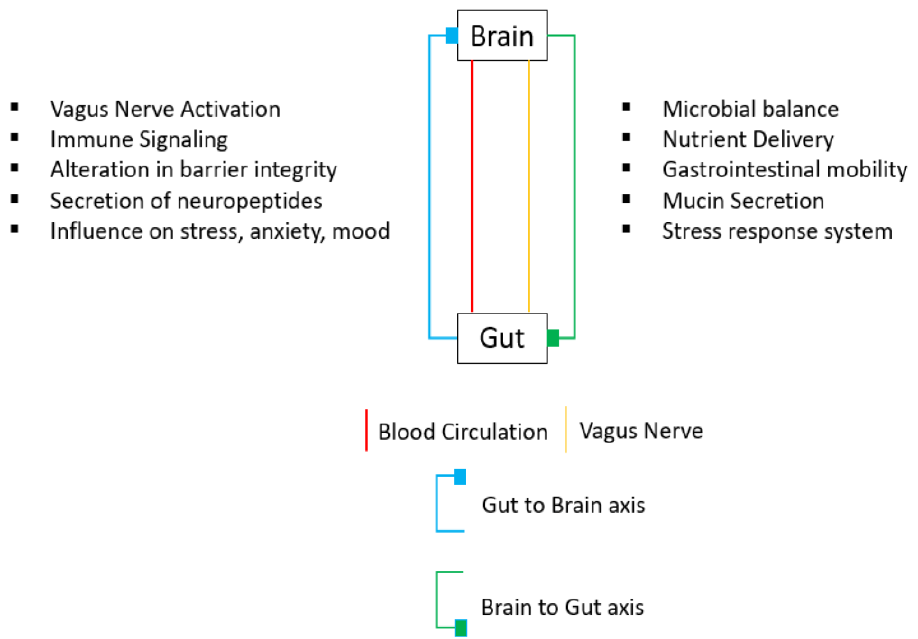
Figure 1. Gut–brain axis. This is a bidirectional axis between the brain and the gut, connected by blood circulation (shown in red) and the vagus nerve (shown in yellow). Through the gut-to- brain axis (shown in blue), the vagus nerve gets activated, the barrier’s integrity gets altered, and neuropeptides and immune signaling molecules are secrete, with an effect on stress and anxiety. Through the brain-to-gut axis (shown in green), the main functions are microbial balance, nutrient delivery, gastrointestinal mobility, mucin secretion, and the stress response